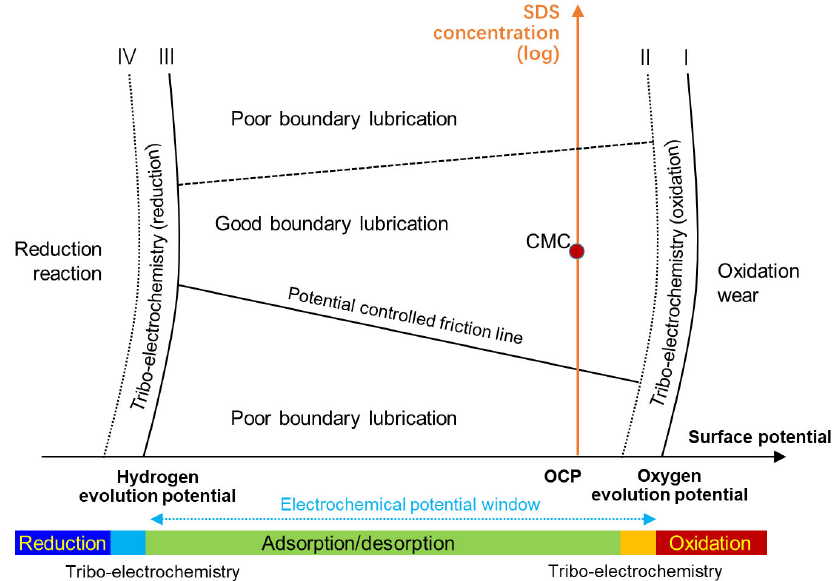
Fig. 8 Schematic diagram combining the electrode processes with the wear map of metal/metal or metal/ceramic tribo-pairs lubricated with different concentrations of anionic surfactant (e.g., SDS) aqueous solutions under different surface